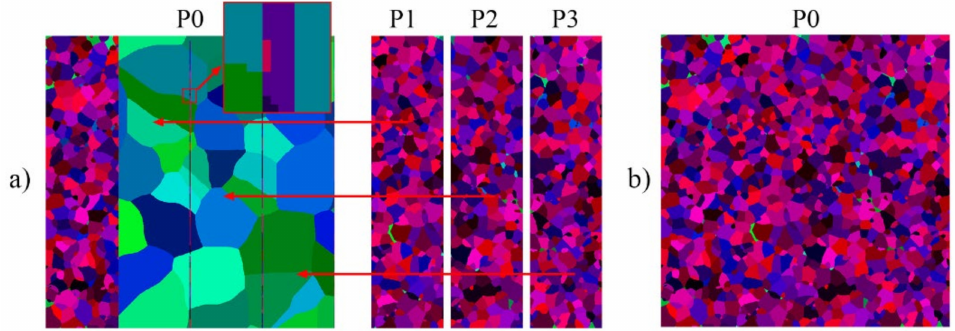
Figure 3. Concept of data agglomeration stage in mode 1 ( a ) data collection by the master process P0, ( b ) restored final microstructure morphology after the SRX